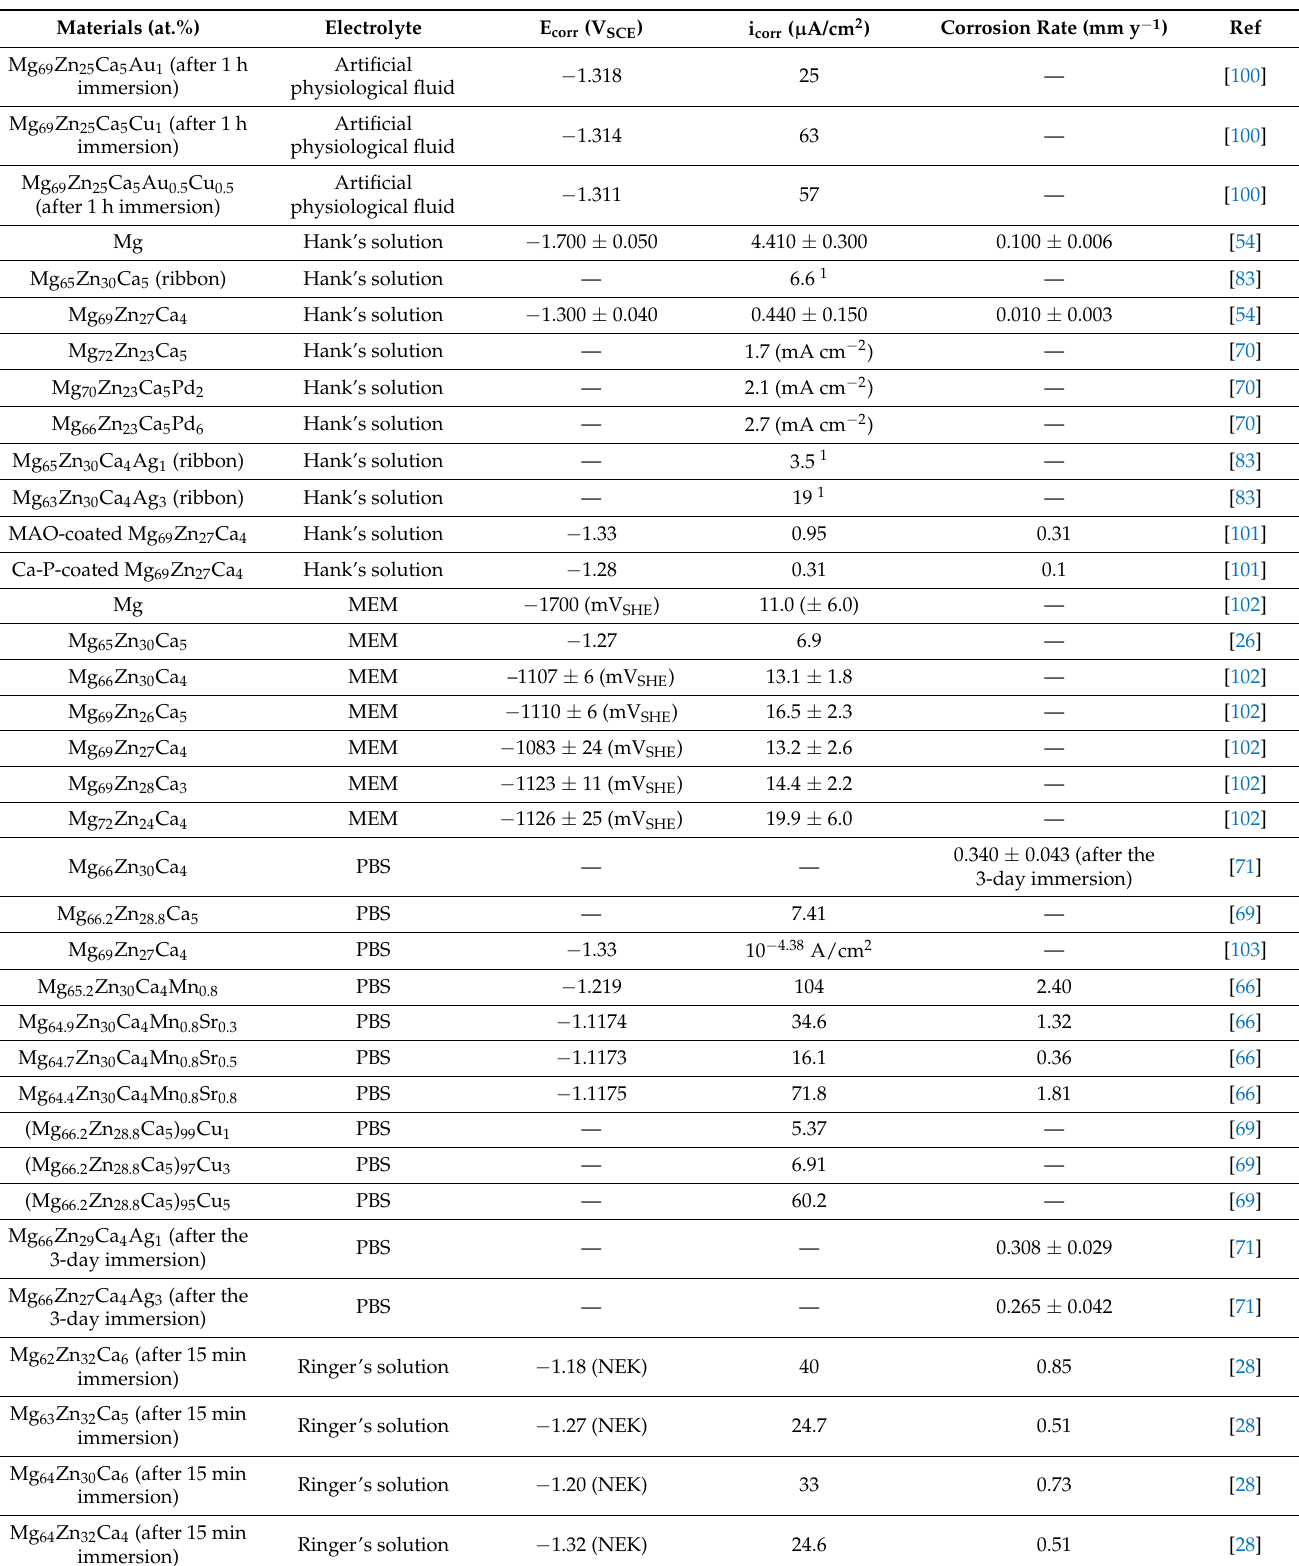
Table 3. Electrochemical corrosion parameters of Mg–Zn–Ca-based